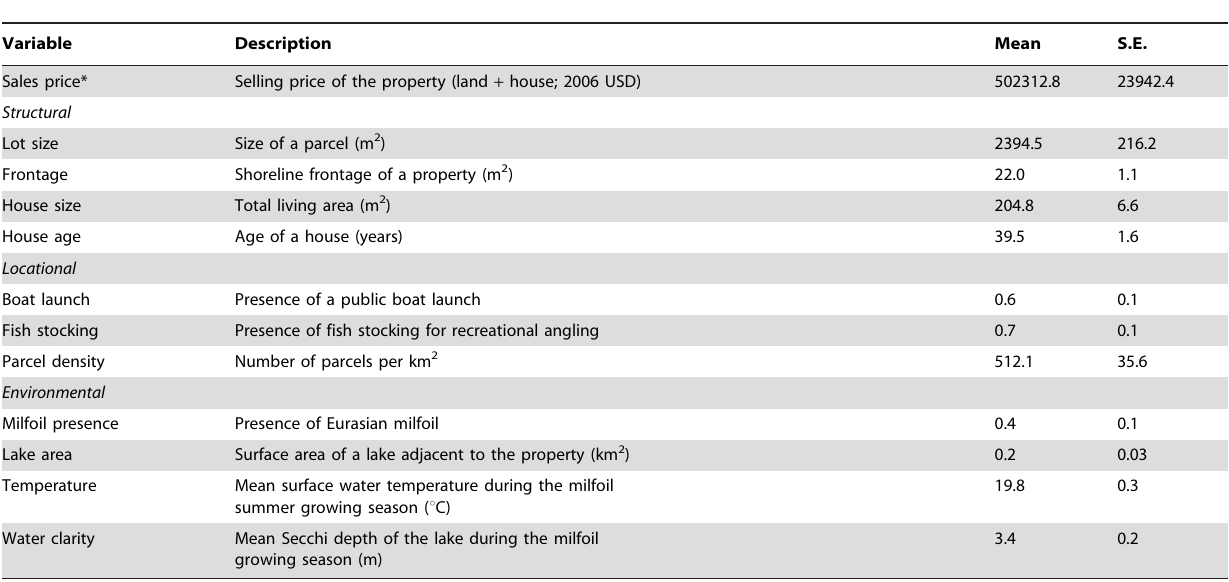
Table 1. Structural, locational, and environmental independent variables used in the hedonic analysis of property sales price